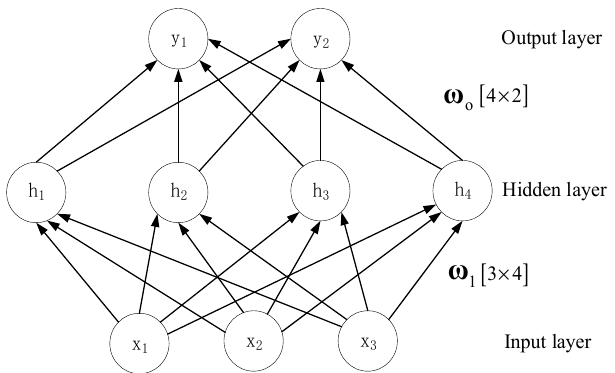
Figure 1. Single-hidden-layer neural network.